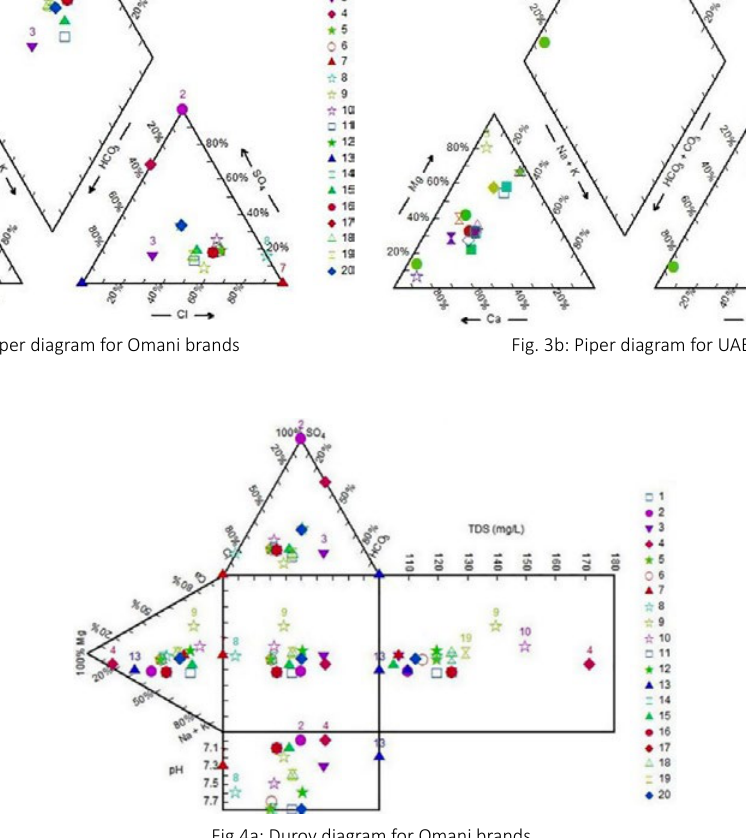
Fig.4a: Durov diagram for Omani brands